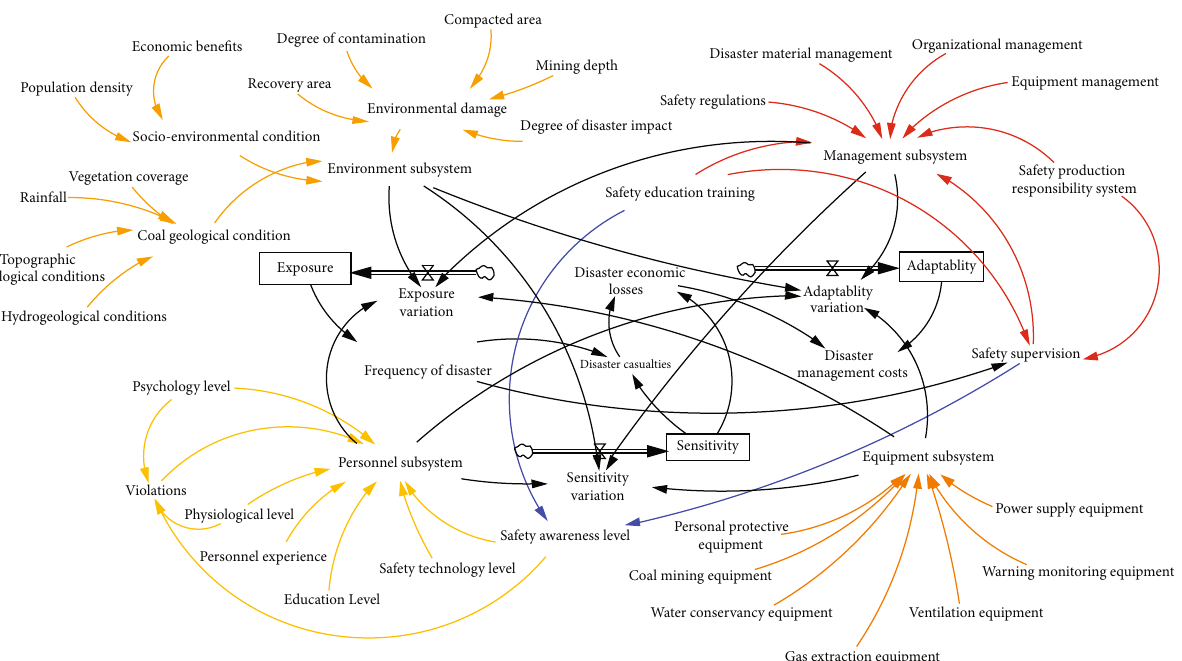
Figure 2: Causal loop.